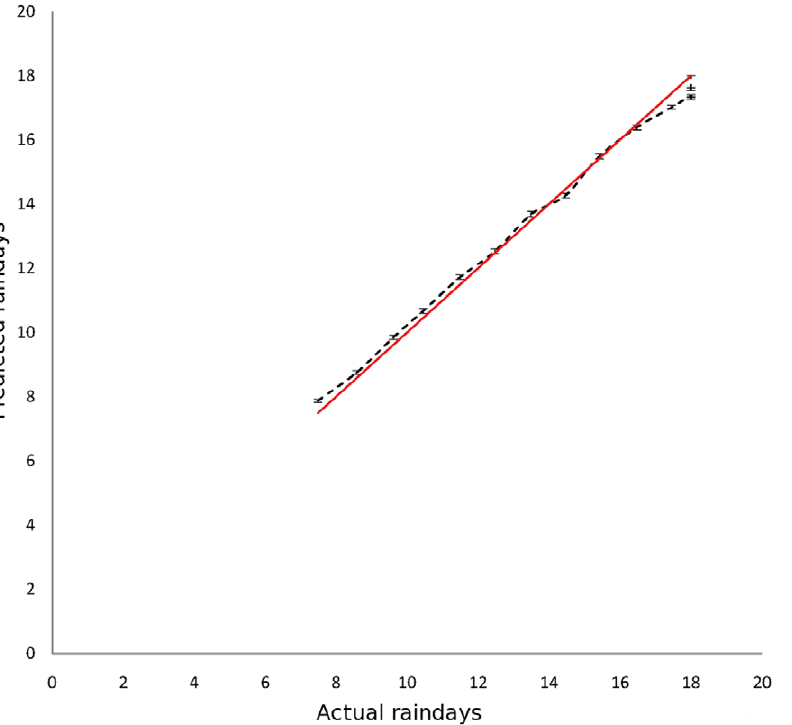
Figure 1. The number of rain days predicted using the GAM against the actual number of rain days (dashed line) ( ± coefficient of variation) . The line of perfect correlation is also shown (solid line).